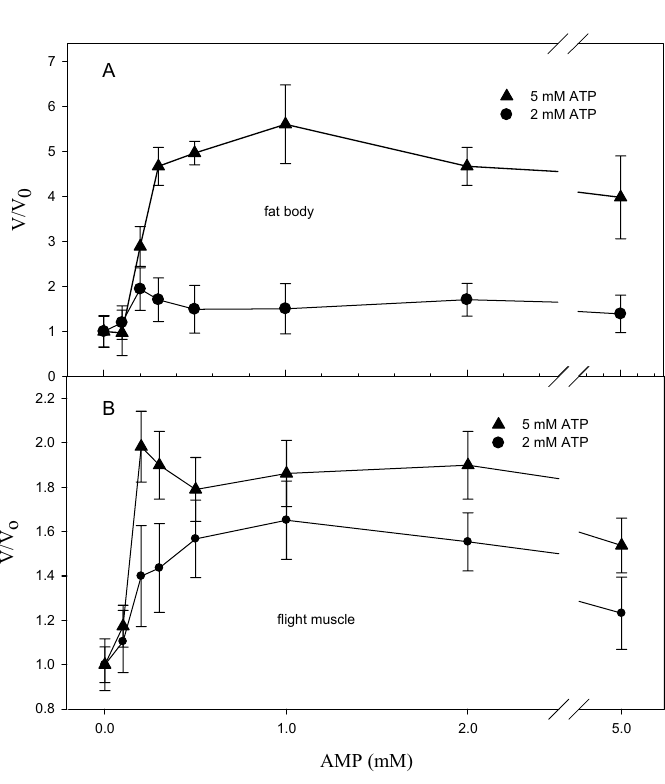
Fig. 6 – Effects of AMP on PFK activity from fat body and muscle homogenates. PFK activity was measured as described on Materials and Methods, in the presence of 5 mM fructose 6-phosphate and 5 mM ATP. Values are means ± SE of at least six independent experiments. Panel A: fat body. Panel B: flight